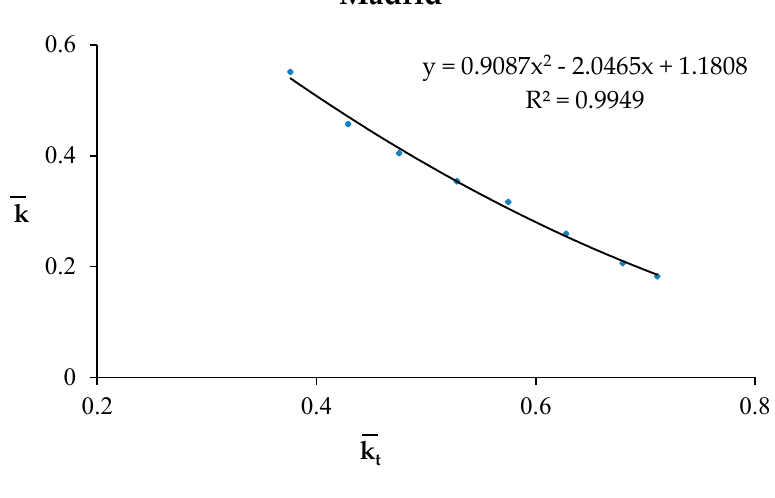
Figure 6. Average values of k vs. k t for Madrid.